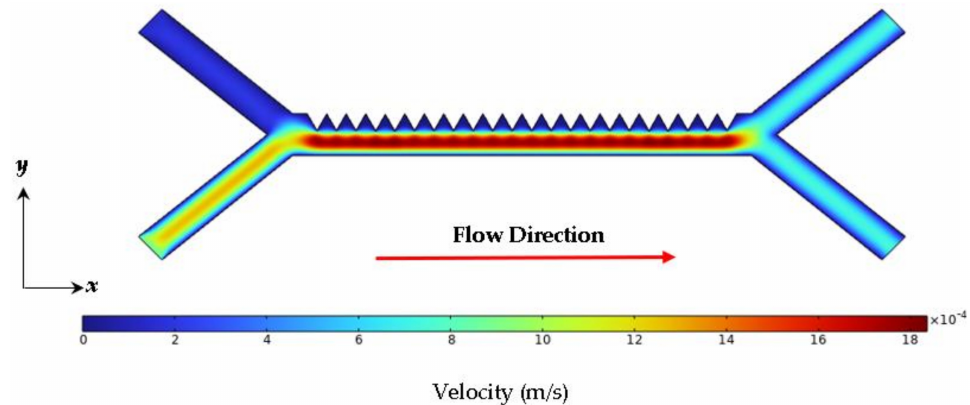
Figure 12. Steady flow of the fluid medium through the microfluidic device